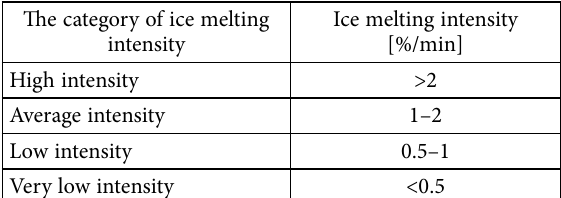
Table 5. Results of the ice melting